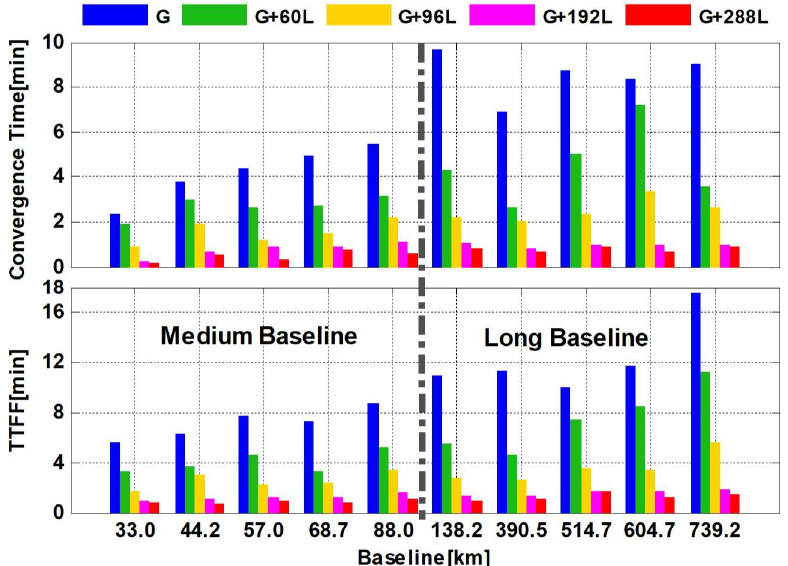
Figure 8. Average convergence time and TTFF of different LEO constellations augmented GPS RTK positioning for ten medium-to-long baselines.